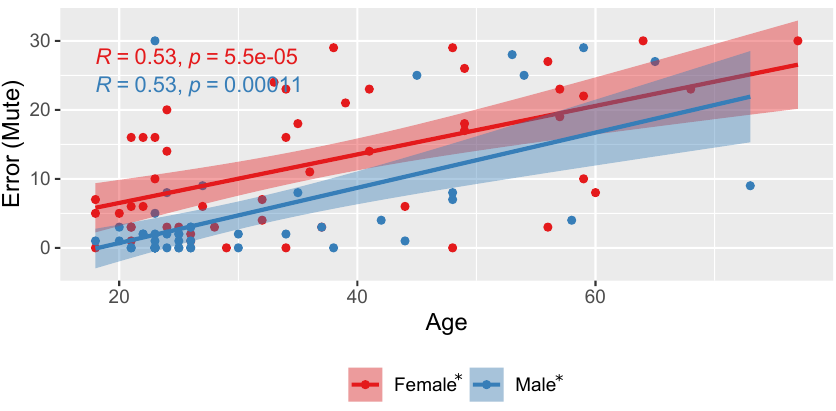
Figure 11. Error versus Age in Sound condition: correlation for males and females displayed using a scatter plot with regression lines and 95% confidence interval. Significant correlations are marked with asterisk.